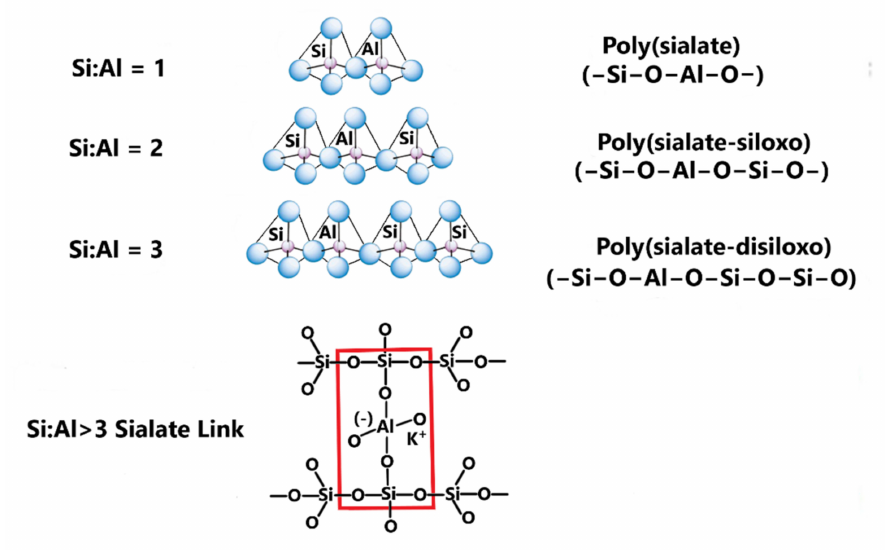
Figure 5. Possible geopolymer